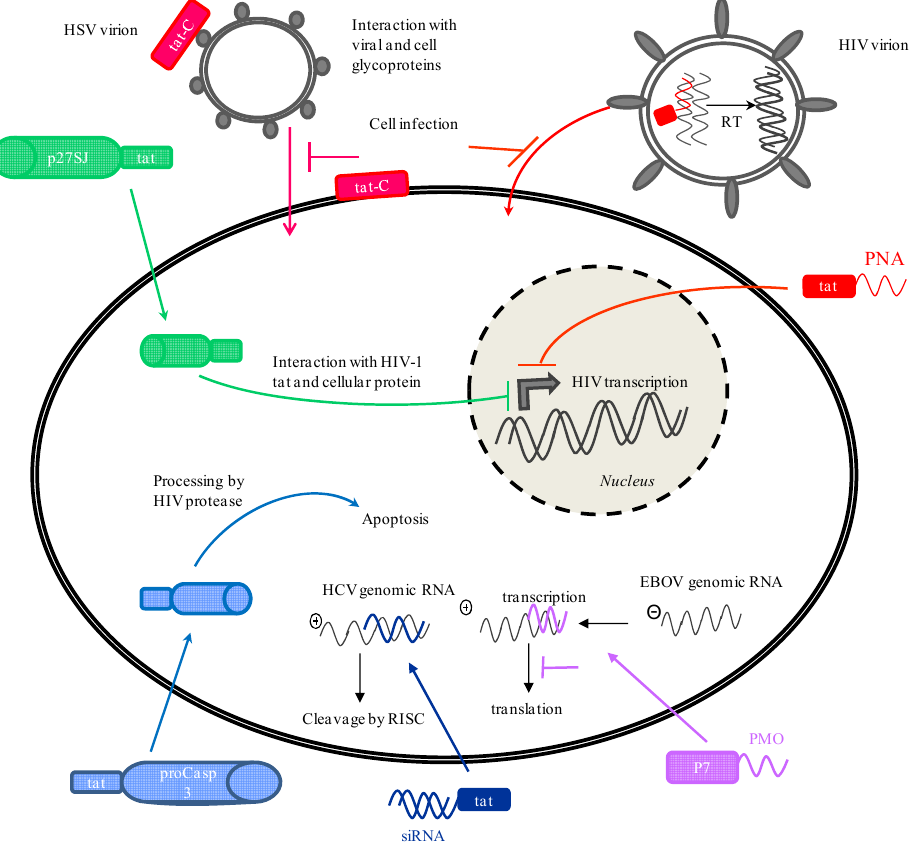
Figure 1. Mechanisms of antiviral activity exerted by CPP conjugates. These antiviral agents can target retroviruses, as shown for HIV, non-retroviral RNA viruses, as shown for the negative-sense RNA EBOV and HCV, and DNA viruses, as shown for HSV. Interference with viral RNA processing and translation further inhibits viral replication. CPP conjugates can also be designed to target virus-infected cells. CPP can also inactivate the virion and render cells resistant to infection, inhibiting cell infection. proCasp3 stands for pro-caspase 3; RT stands for reverse transcription; Tn stands for